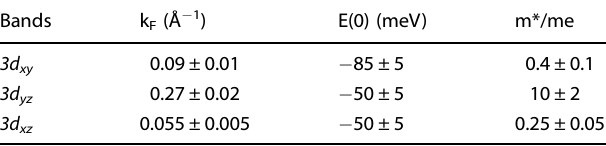
Table 1. Fermi momentum k F , band bottom E(0) and effective mass of the various bands. Bands